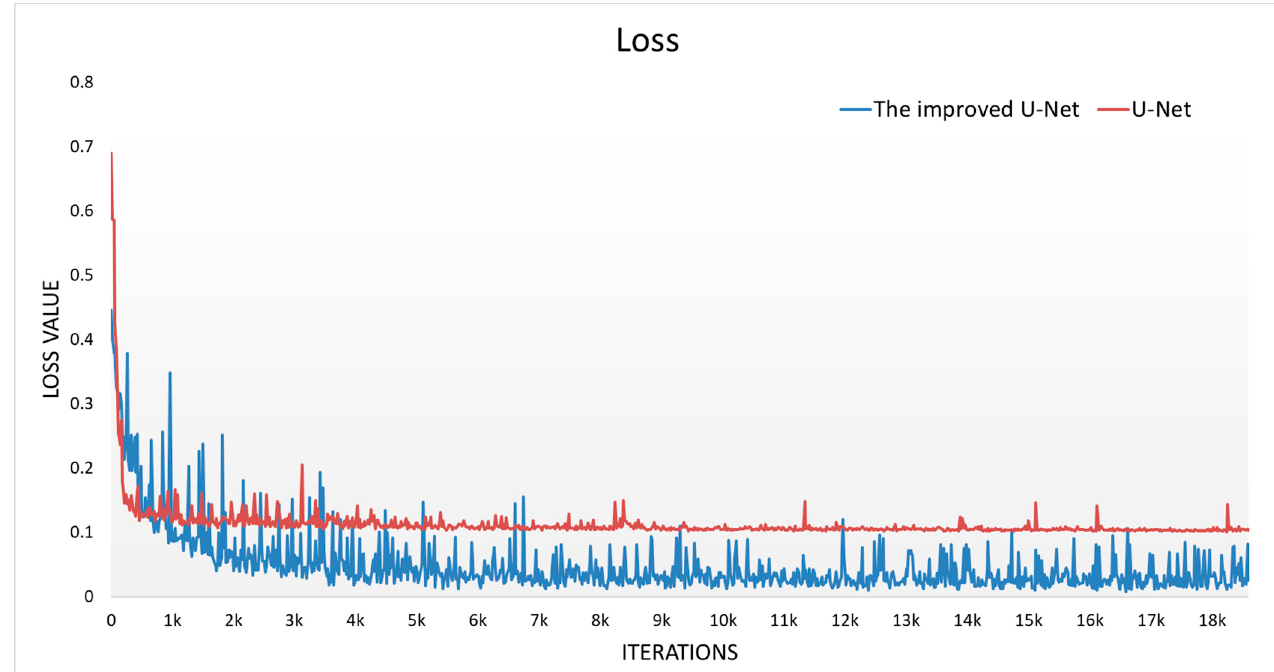
Figure 12. Loss curves of the U-Net and the improved U-Net.